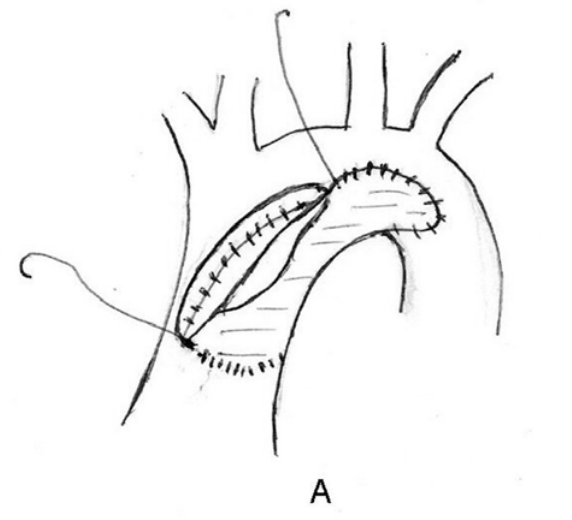
Fig. 3 – Implante de um retalho de tecido plástico ou biológico não autógeno, na operação de Norwood. Retalhos que não crescem com o tempo